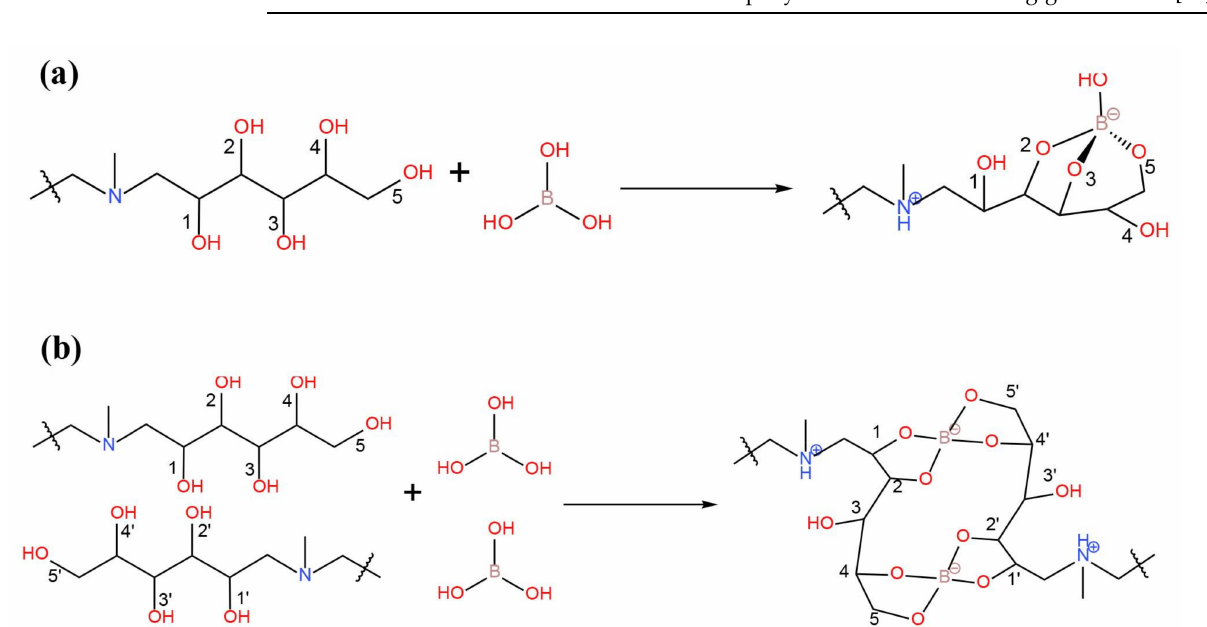
Figure 7. Representative scheme of boric acid chelation by N-methyl-D-glucosamine with ( a ) triden- tate 2,3,5-isomer and ( b ) 1,2,4 (cid:48) ,5 (cid:48) -4,5,1 (cid:48) ,2 (cid:48) bischelate. Reproduced based on